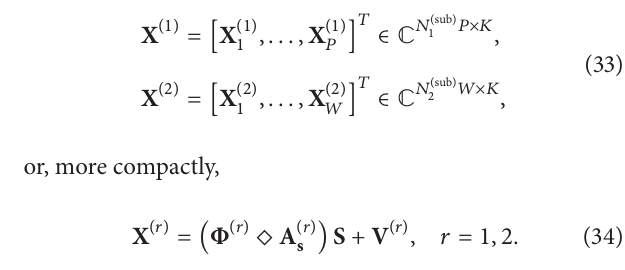
Figure 1: L -shaped array configuration with 𝑁 1 +𝑁 2 −1 sensors. The distance between the sensors in the 𝑧 -axis is 𝑑 (1) while the distance between the sensors in the 𝑥 -axis is 𝑑 (2) . The 𝑚 th wavefront has elevation and azimuth angles equal to 𝛼 𝑚 and 𝛽 𝑚 ,